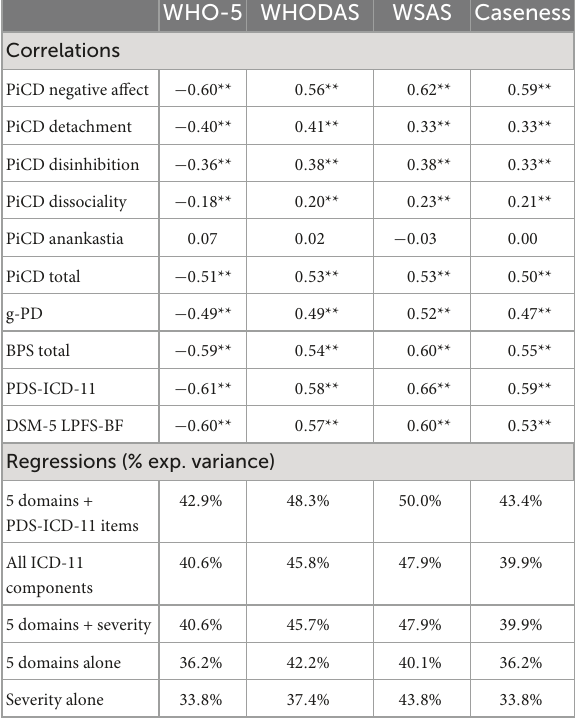
TABLE 2 Correlations of the ICD-11 components with external indicators of well-being, disability, and clinical problems, and multiple regressions of indicators on ICD-11